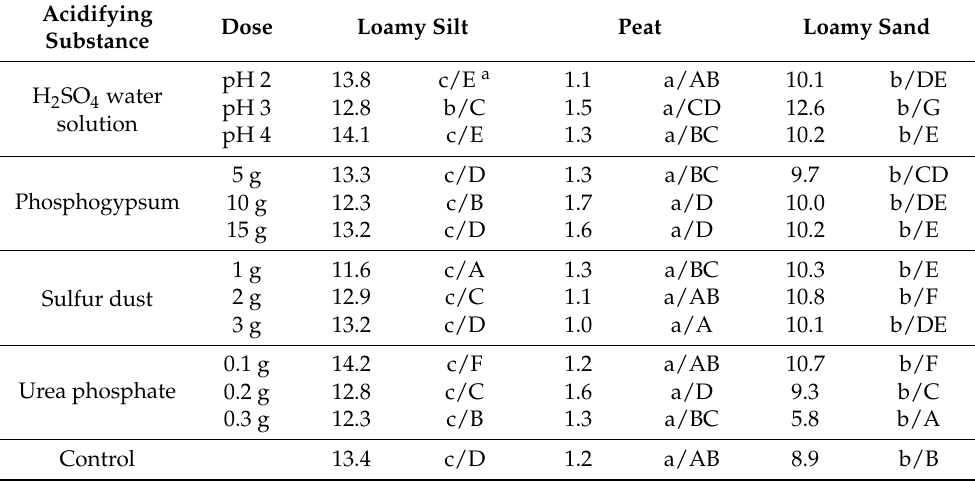
Table 11. Effects of acidifying substances after 12 months on the content of available copper in loamy silt, peat and loamy sand